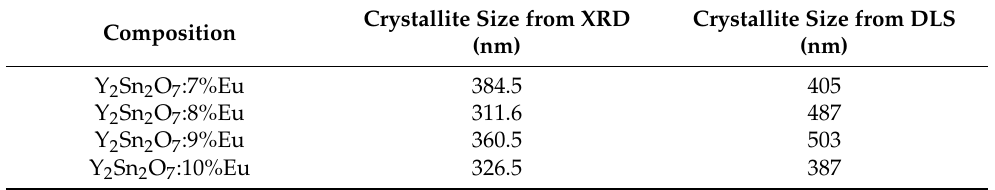
Table 2. Average crystallite